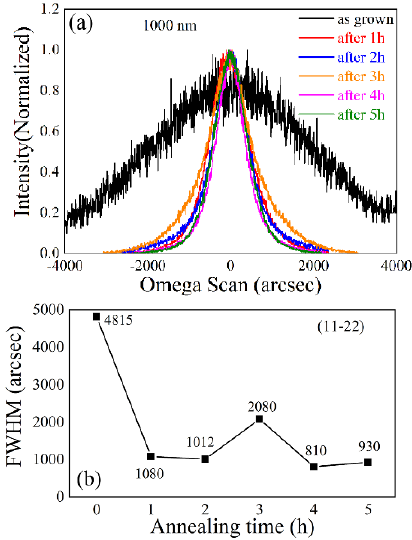
Figure 6. ( a ) XRD rocking curves and ( b ) corresponding FWHMs of (11–22) plane of 1000 nm-thick AlN annealed under different durations.